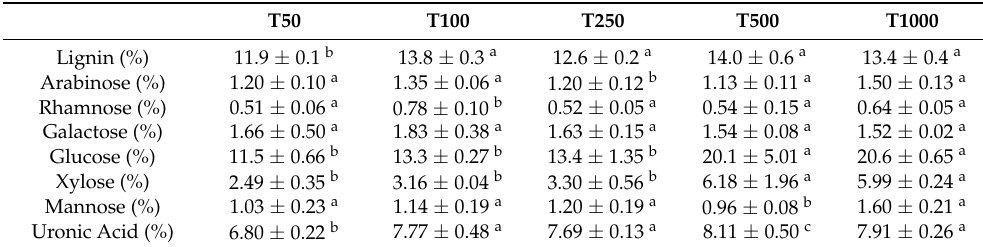
Table 2. Biochemical composition of the tomato plant particle samples. All lignin and monosaccharide concentrations are expressed in percentage of dry